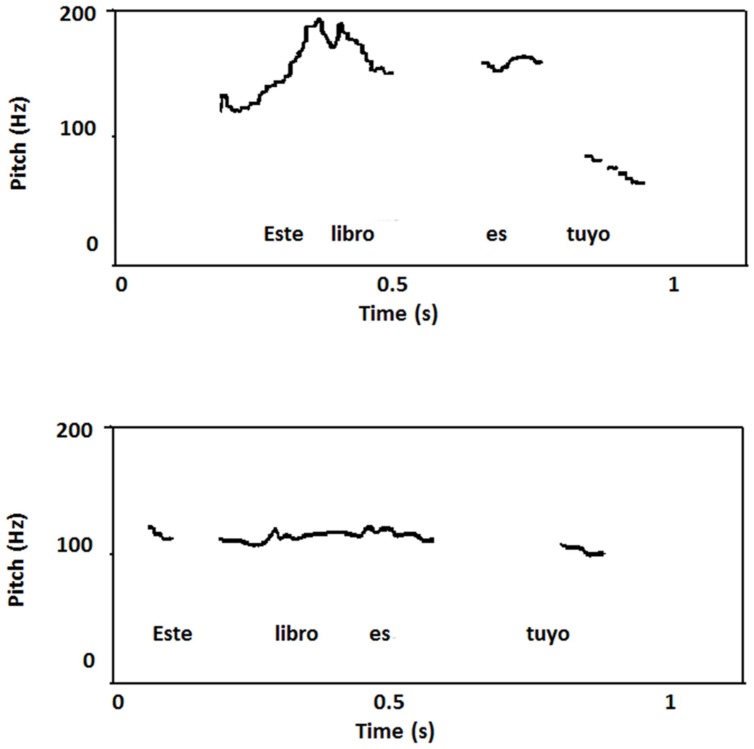
Plot of the Spanish sentence “Este libro es tuyo” (“This book is yours”) pronounced by a healthy control subject with typical Corrientes’s accent (top) and patient JF (bottom). The healthy control showed a higher rate of declination than patient JF who underwent small rise and fall movements giving a flat contour with some resetting effects. Limited movements of the F0 curve most likely contributed to the impression of a flat intonation.